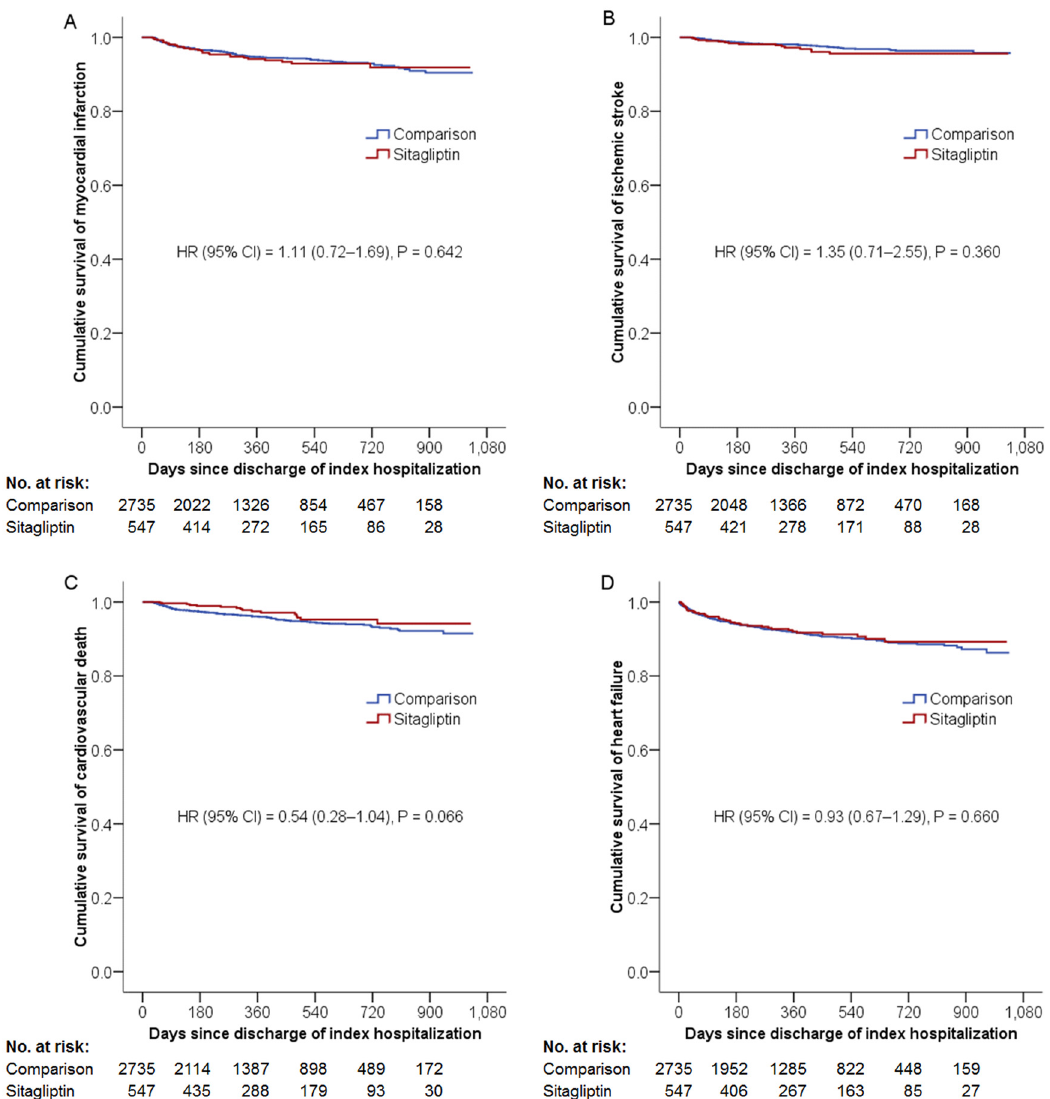
Fig 3. Cumulative Kaplan-Meier survival estimates of the time to individual components of the primary composite endpoint and heart failure hospitalization. The sitagliptin and comparison groups had similar incidence of individual components of the primary composite endpoint, such as AMI (Panel A), ischemic stroke (Panel B), cardiovascular death (Panel C), and hospitalization for heart failure (Panel D).